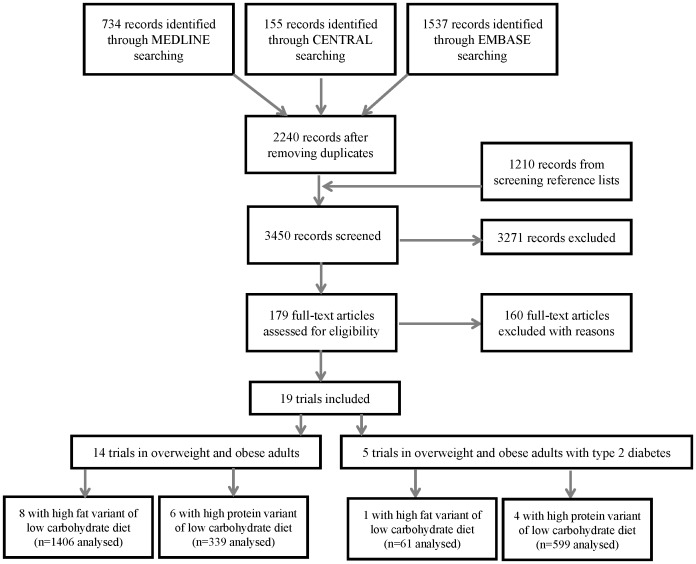
Flow diagram illustrating the search results and selection process, as well as the variants of the low carbohydrate diets used as treatments in the included trials.The high fat variant of low carbohydrate diets is low in carbohydrates (<45% of total energy), high in fat (>35% of total energy) and high in protein (>20% of total energy). The high protein variant of low carbohydrate diets is low in carbohydrates (<45% of total energy), has a recommended proportion of fat (20 to 35% of total energy) and is high in protein (>20% of total energy).